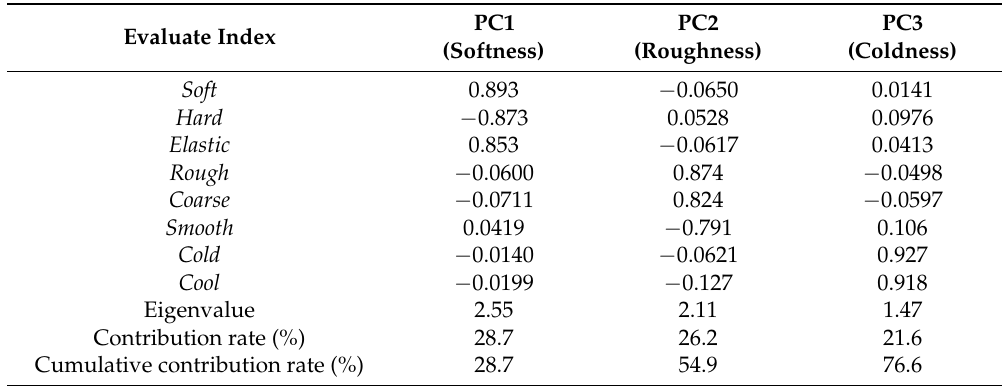
Table 2. Results obtained from the principal component